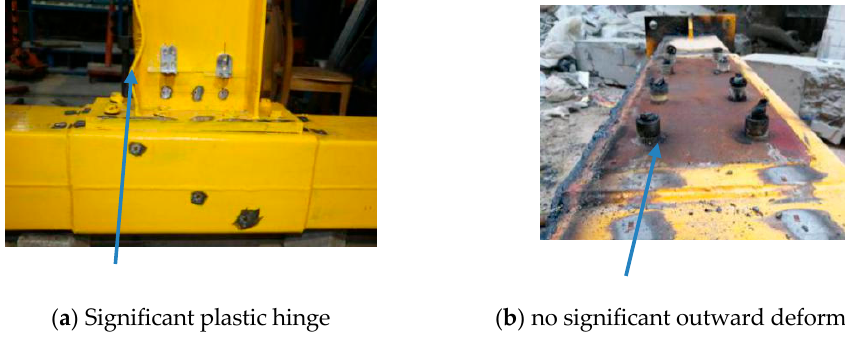
Figure 11. Failure mode III. ( a ) SJ-7; ( b ) Column wall in specimen SJ-7.